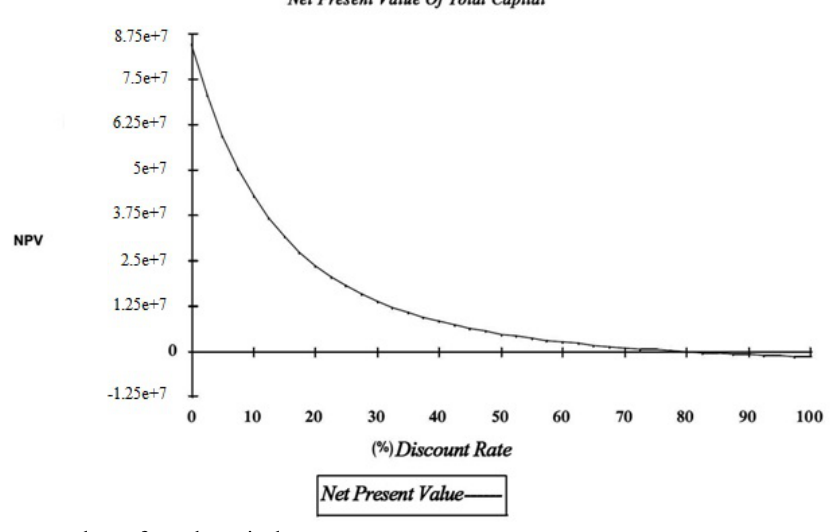
Figure 2. Net present value of total